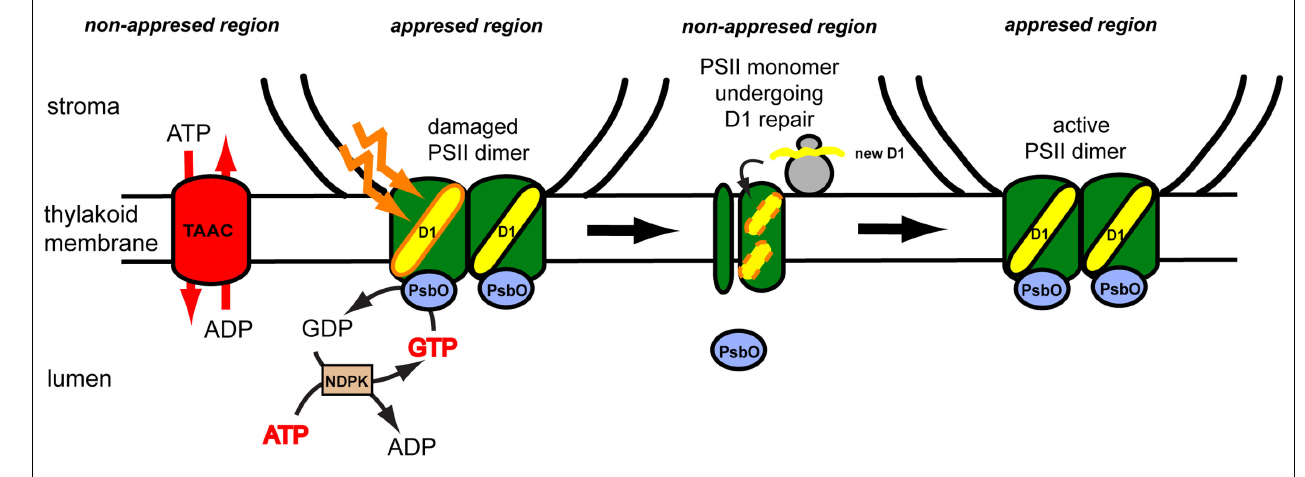
PsbO proteins. During illumination with excess light, the reaction center D1 protein may be oxidatively damaged and needs to be replaced.The PsbO subunit of the damaged monomer binds and hydrolyzes GTP, leading to its dissociation and partial disassembly of the monomeric complex on the way to the stroma-exposed regions. Here the D1 protein is degraded and replaced with a new copy synthesized by the chloroplast ribosomes and co-translationally inserted in the membrane. Monomers assemble into the dimers and migrate to the grana